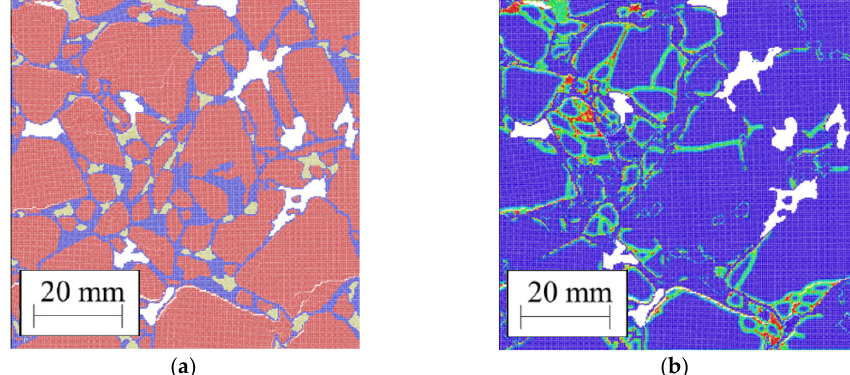
Figure 12. Changes of 𝛽 with void %.